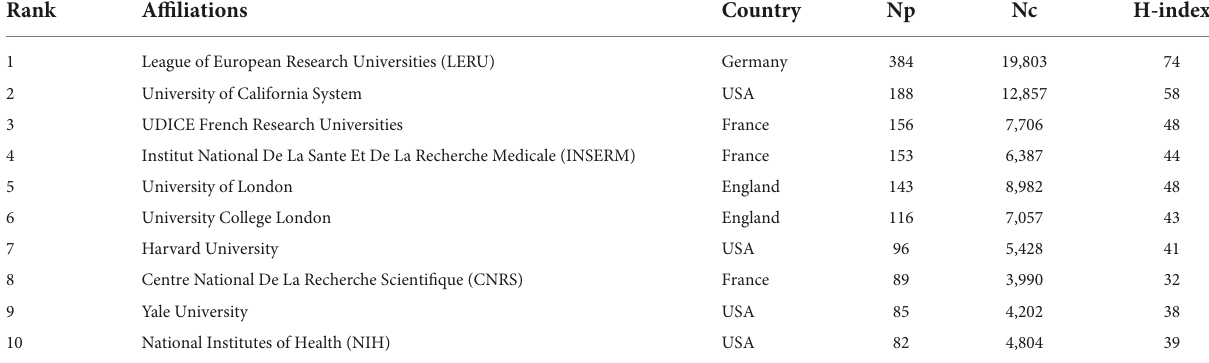
TABLE 2 Top 10 affiliations with most